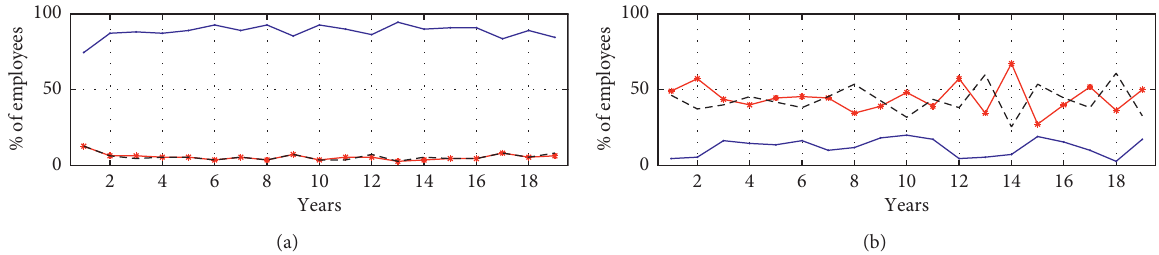
Figure 10: (a) % of employees which does not change rank from t − 1 to t in blue circle line, % of employees which improves rank position from t − 1 to t in black dashed, and % of employees which worsens rank position from t − 1 to t in red star line. (b) % of employees which does not change their performance from t − 1 to t in blue circle line, % of employees which improves their performance from t − 1 to t in black dashed, and % of employees which worsens their performance from t − 1 to t in red star line.